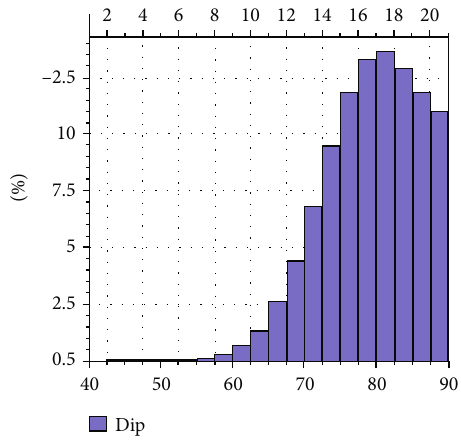
Figure 16: Histogram of fracture dip